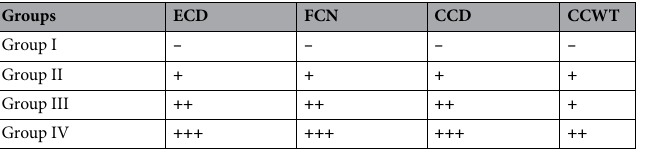
Table 3. Effect of MnCl 2 toxicity on root meristem cells. Group I: Control, Group II: 250 µM MnCl 2 , Group III: 500 µM